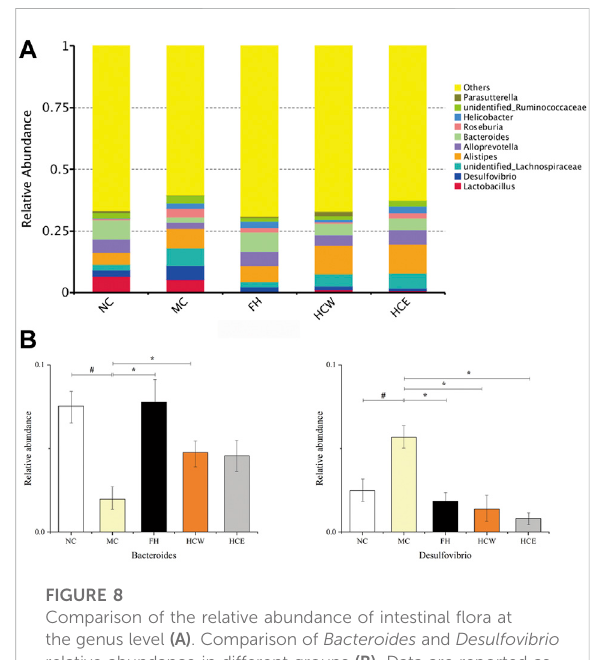
FIGURE 7 Comparison of the relative abundance of intestinal fl ora at the phylum level (A) . Comparison of Firmicutes and Bacteroidetes relative abundance in different groups (B) . Data are reported as mean ± SD. For statistical signi fi cant, ## p < 0.01 compared with the normal control group; ** p < 0.01 compared with the model control group. NC, normal group; MC, model group; FH, Fluoxetine hydrochloride group; HCW, water extract of fl owers; HCE, 80% ethanol extract of fl owers.